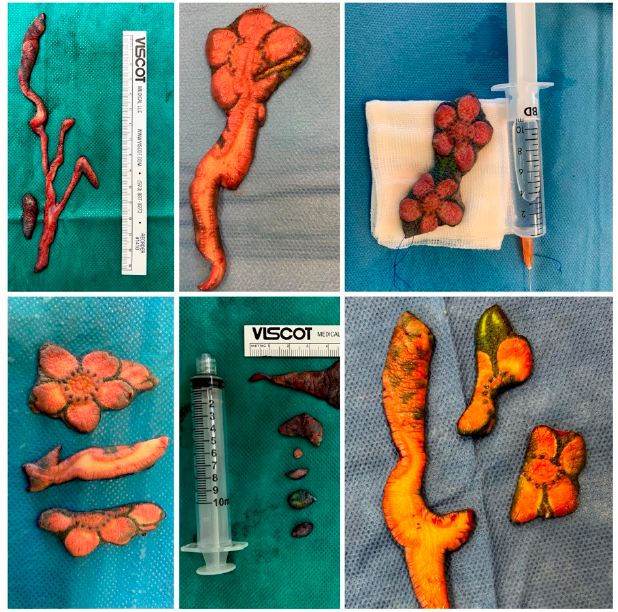
Figure 3. Excised parts of the tattoo of the right forearm with skin changes.